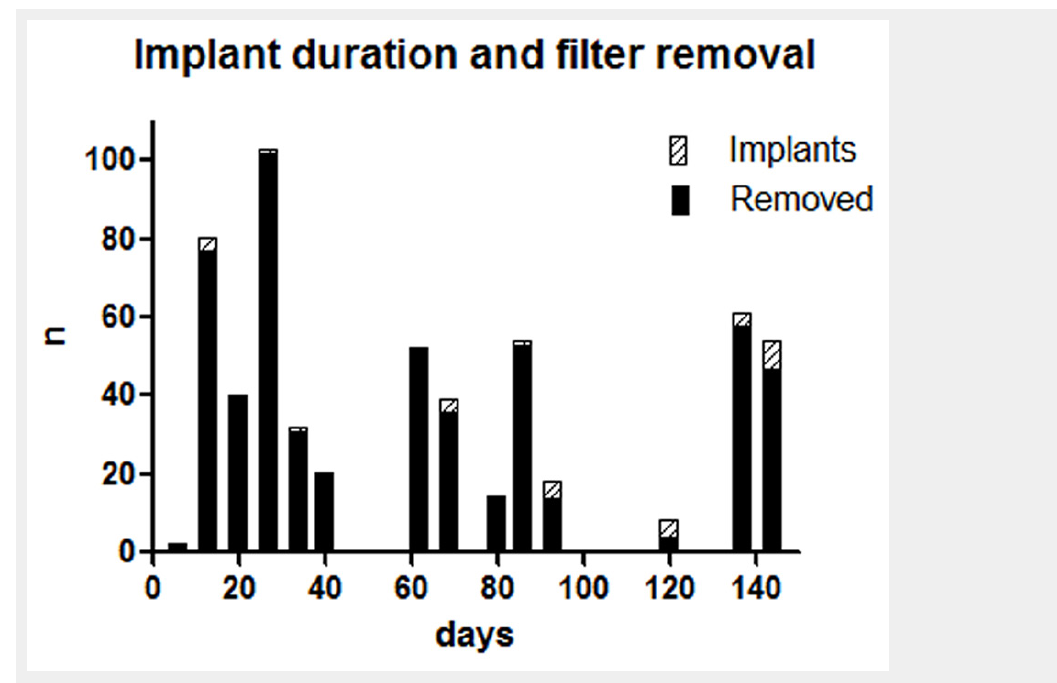
Figure 2 Proportion of filters removed over time. It is interesting to note, that up to 84 days, 100% filter removal can be obtained by conventional means (hooks and